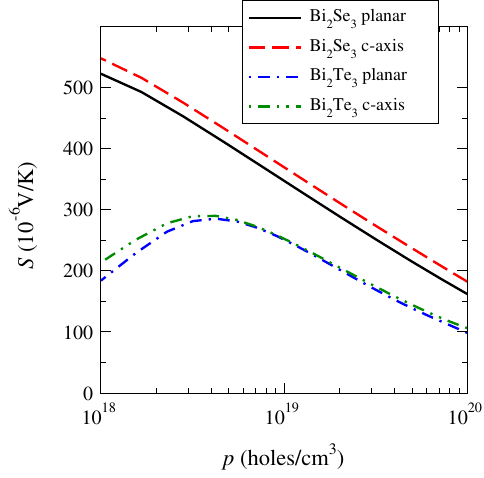
FIG. 3. The calculated thermopower for Bi 2 Se 3 and Bi 2 Te 3 at 300 K.